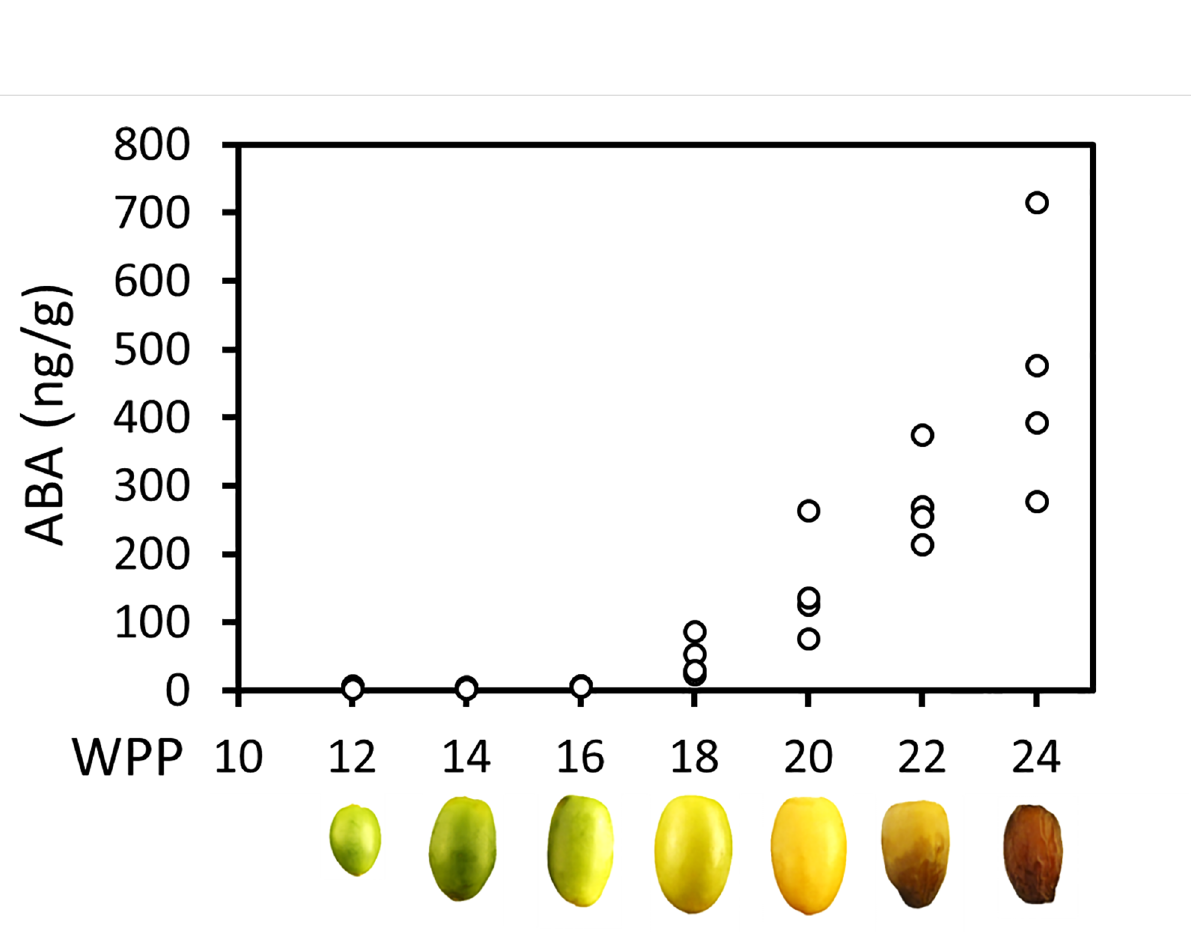
FIGURE 4 Endogenous ABA level increase throughout date palm fruit ripening. Endogenous ABA levels in representative fruits were quanti fi ed along the course of fruit development (Gro fi t 2017), using LC-MS. At each time point, four independent fruits served as biological replicates. ABA content was normalized to fresh